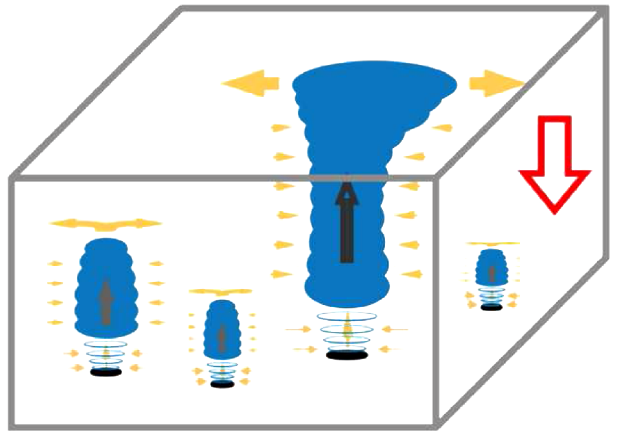
Figure 1. Illustration of the heterogeneous convective clouds repre- sented by CCFM in a GCM grid box, including the newly included subcloud dry